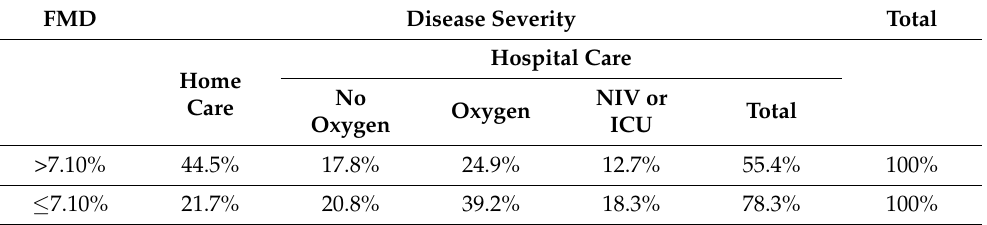
Figure 2. Distribution of disease severity according to flow-mediated dilation ( p = 0.0001 at chi- squared test). Table 4. Distribution of disease severity according to binary flow-mediated dilation ( p < 0.0001 at chi-squared test).